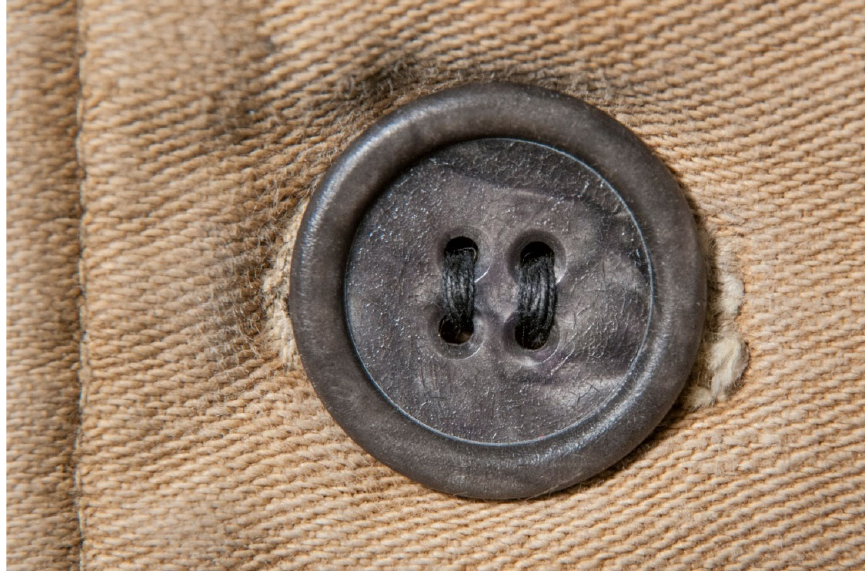
Figure 1. Button from a miner’s jacket with craqueled surface.